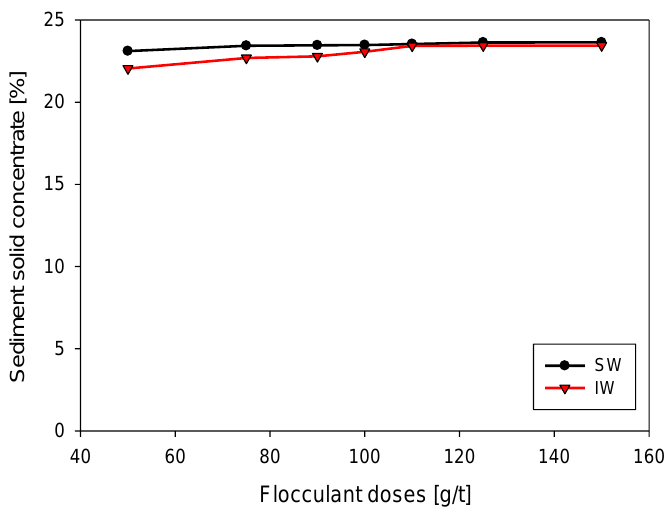
Figure 10. Effect of flocculant dosage on solids concentration in kaolin sediment in IW and SW. Stirring rate 180 rpm, solids concentration 5 wt%, flocculation time 15 s, and pH 7.